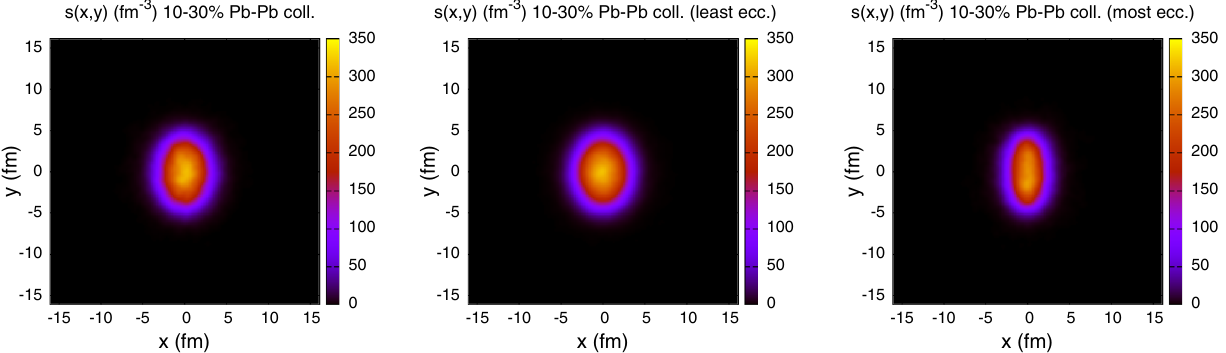
√ s NN = 5 . 02 TeV. The three panels refer to no eccentricity